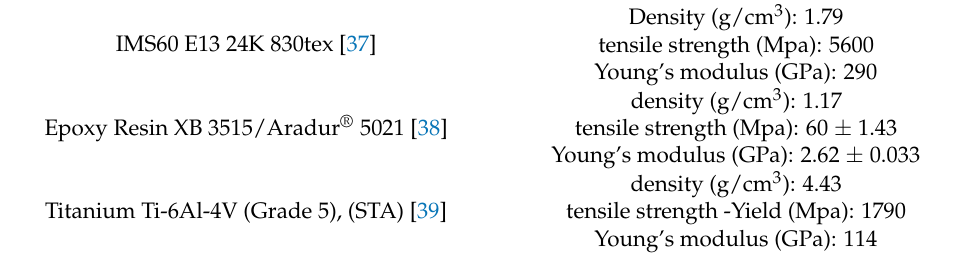
Table 1. Material properties of the UD prepreg tape and the titanium